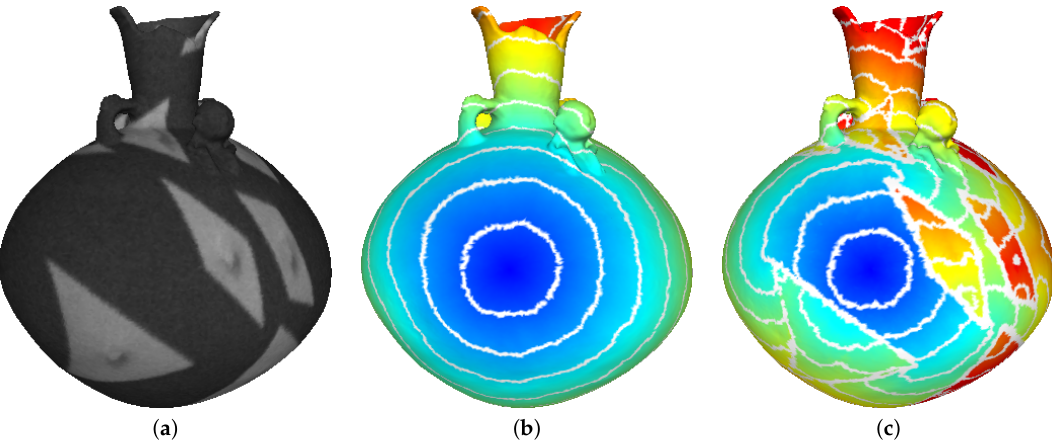
Figure 8. Generalized distance on the mesh with the Eikonal equation on the graph. From left to right: ( a ) original mesh; ( b ) result with w = 1; ( c ) result with w that depends on the vertices’ colors (see Section 4.2.1). Blue and red color show low and high distances, respectively. White lines display